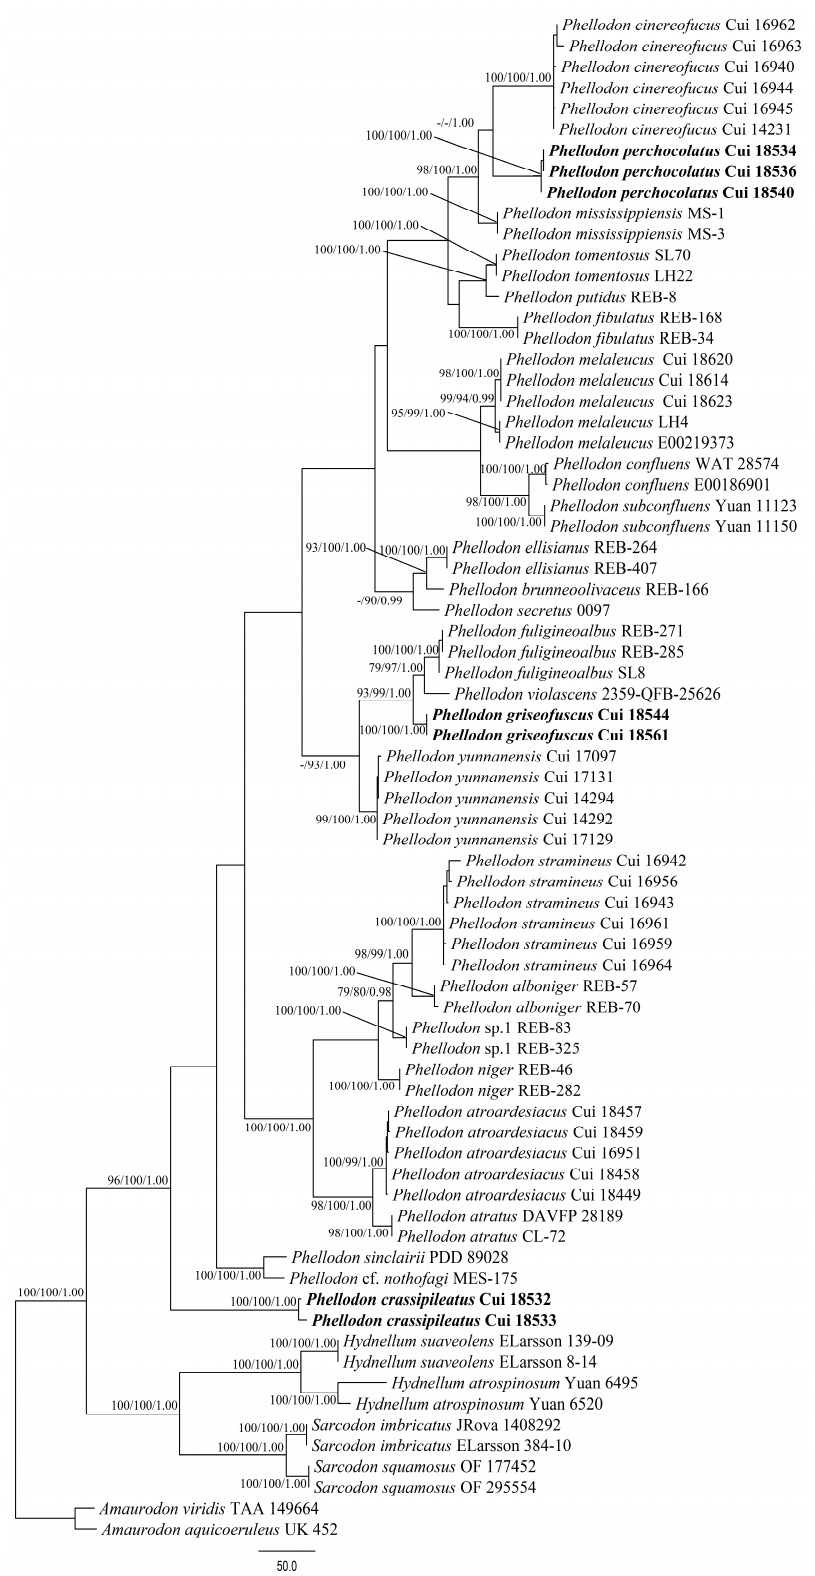
Figure 2. Maximum parsimony (MP) phylogram of the Phellodon species based on the combined ITS + nLSU + nSSU + RPB1 + RPB2 sequences data. The supported branches are labeled with parsimony bootstrap values higher than 75%, maximum likelihood bootstrap values higher than 75%, and Bayesian posterior probabilities more than 0.95. Bold names = New species.